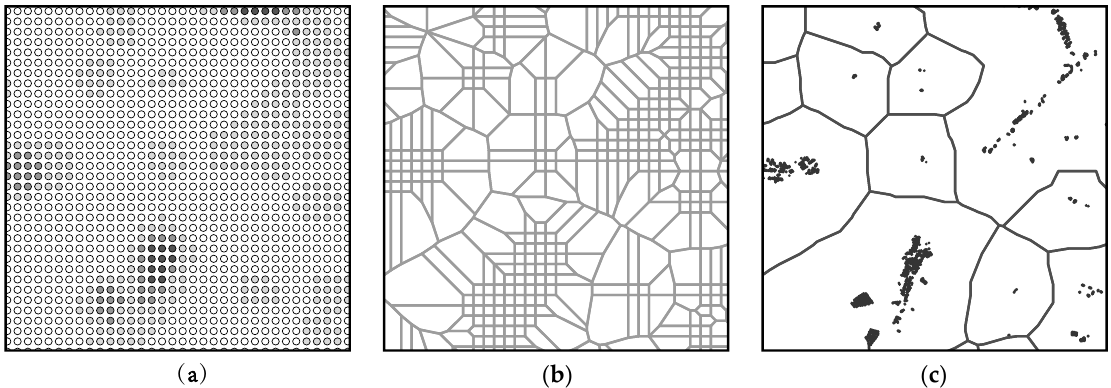
Figure 3. Cartographic partitioning process: ( a ) point raster with different density values represented by shades of grey from white = 0 to black = 1; ( b ) Voronoi diagram of selected points; and ( c ) original buildings (dark grey) and boundaries of the final cartographic partitions (light grey). Scale 1:100,000 ( source : own illustration based on data from official building polygons, ATKIS ® -Base-DLM © Geobasis-DE/BKG